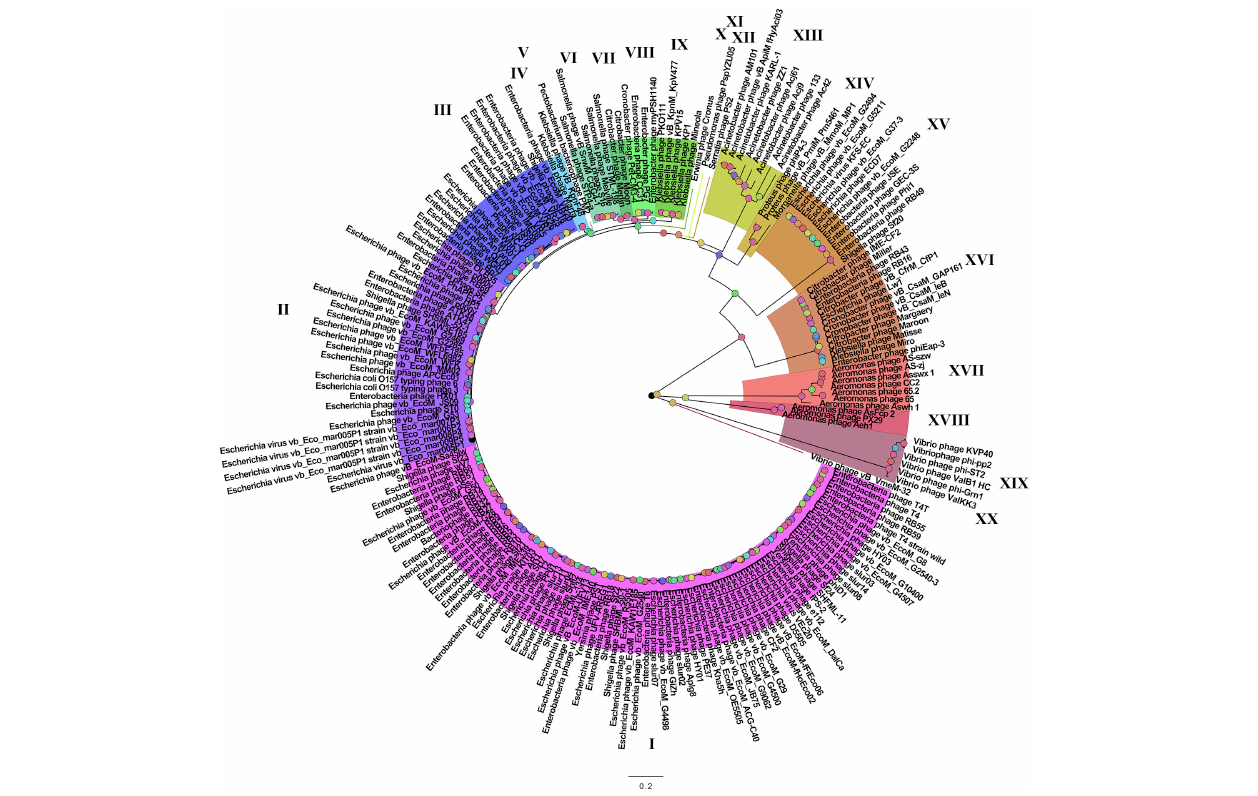
FIGURE 1 | The pan-genomic tree of Tevenvirinae . Selective clades are marked with Roman numerals and colors. The statistical values presented along with the tree in Supplementary Figure 2 are marked with colored circles.